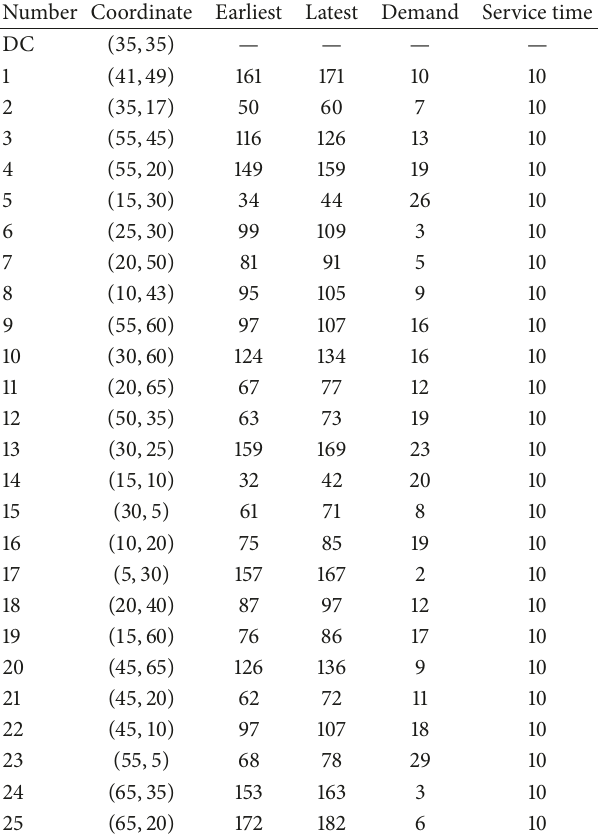
Table 1: Position coordinates and time windows.